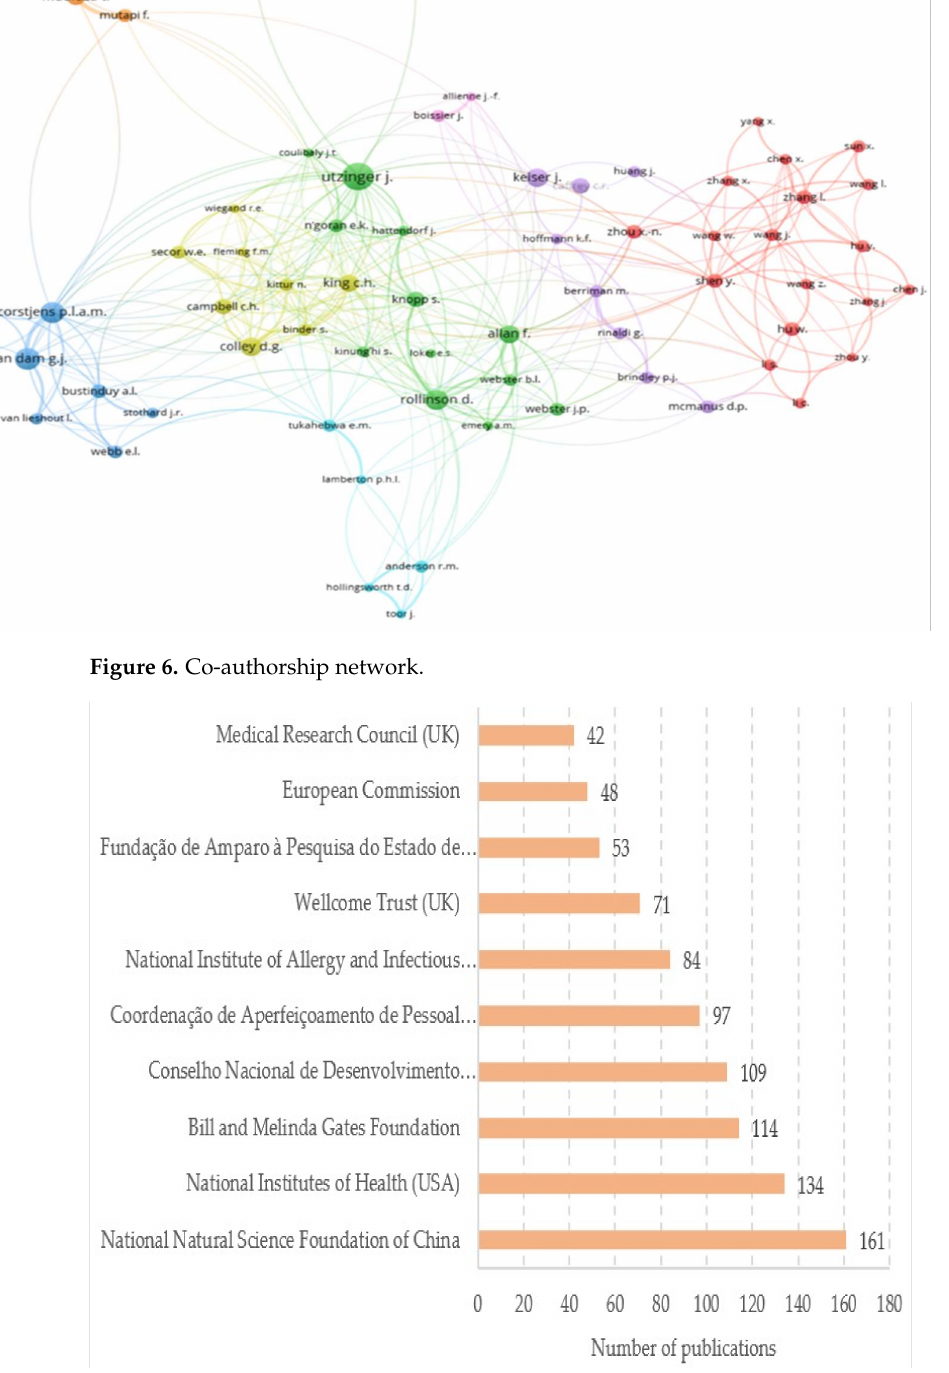
Figure 7. The top 10 funding